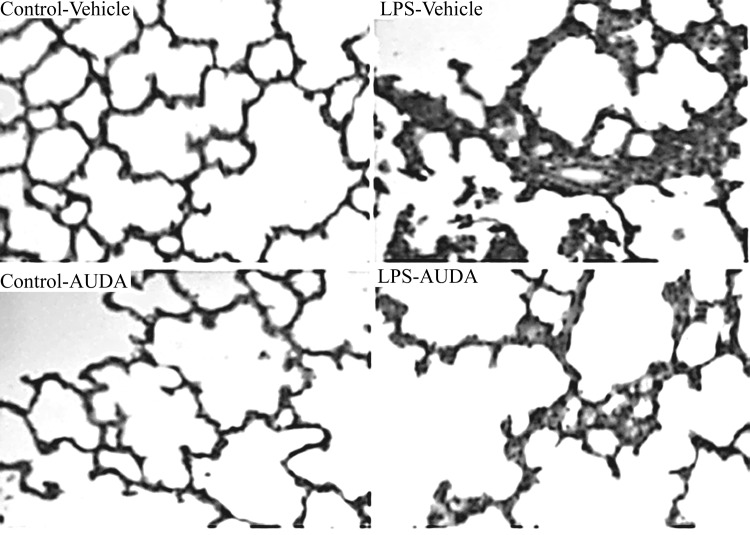
Morphologic alterations of the lungs were determined by photomicrography (400× magnification).Infiltration of neutrophils and pulmonary septal widening were presented in lipopolysaccharide (LPS) +vehicle group 24 h after LPS challenged. These changes were improved in AUDA treated group.